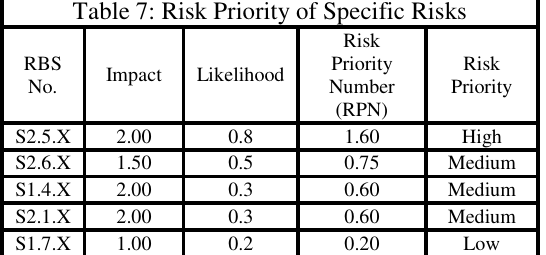
Table 7: Risk Priority of Specific Risks RBS No.